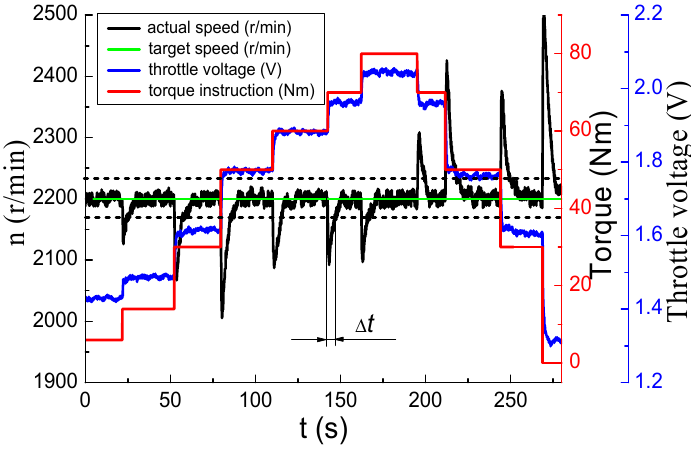
Figure 14. Disturbance stability test results.